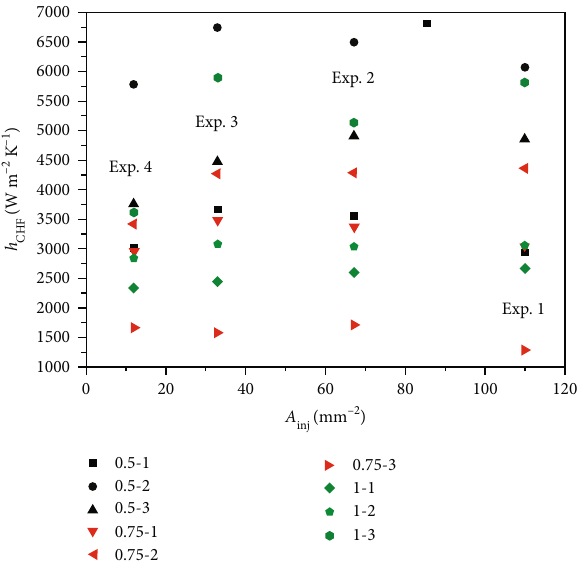
Figure 19: Experimental h